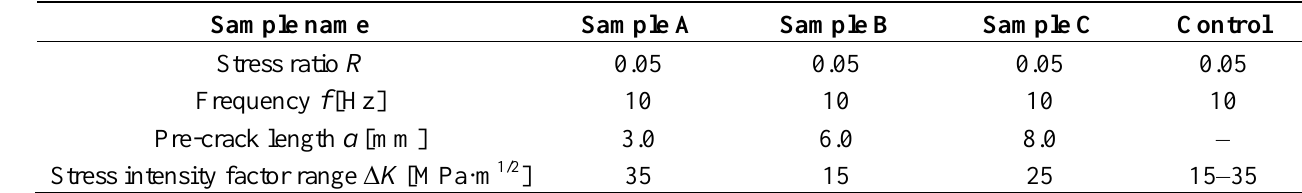
Table 1. Conditions of fatigue test.